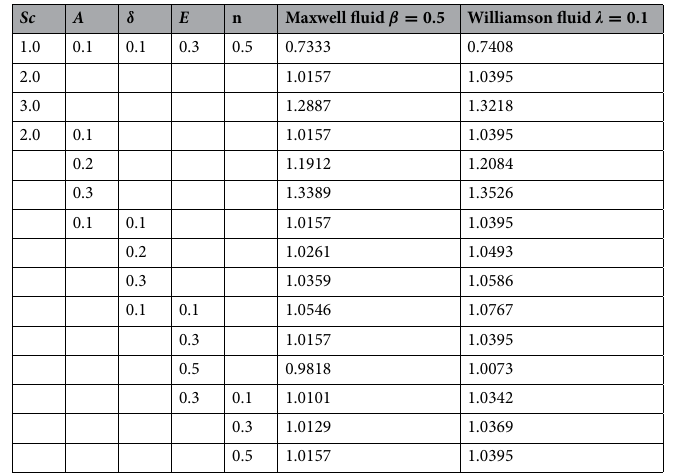
Table 4. Results for